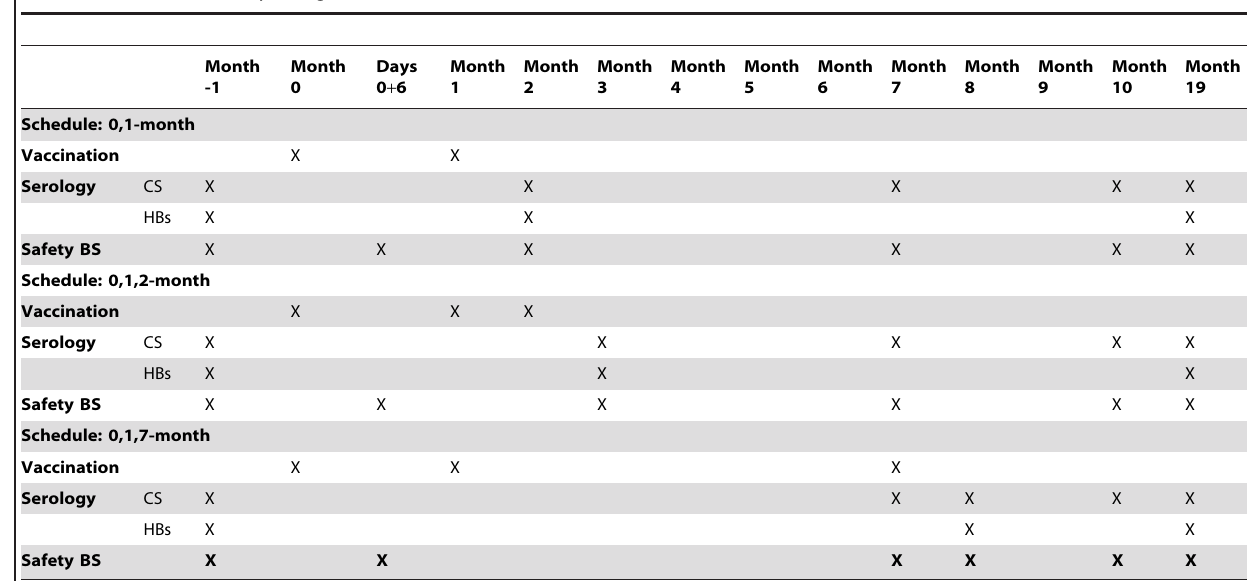
Table 1. Outline of study